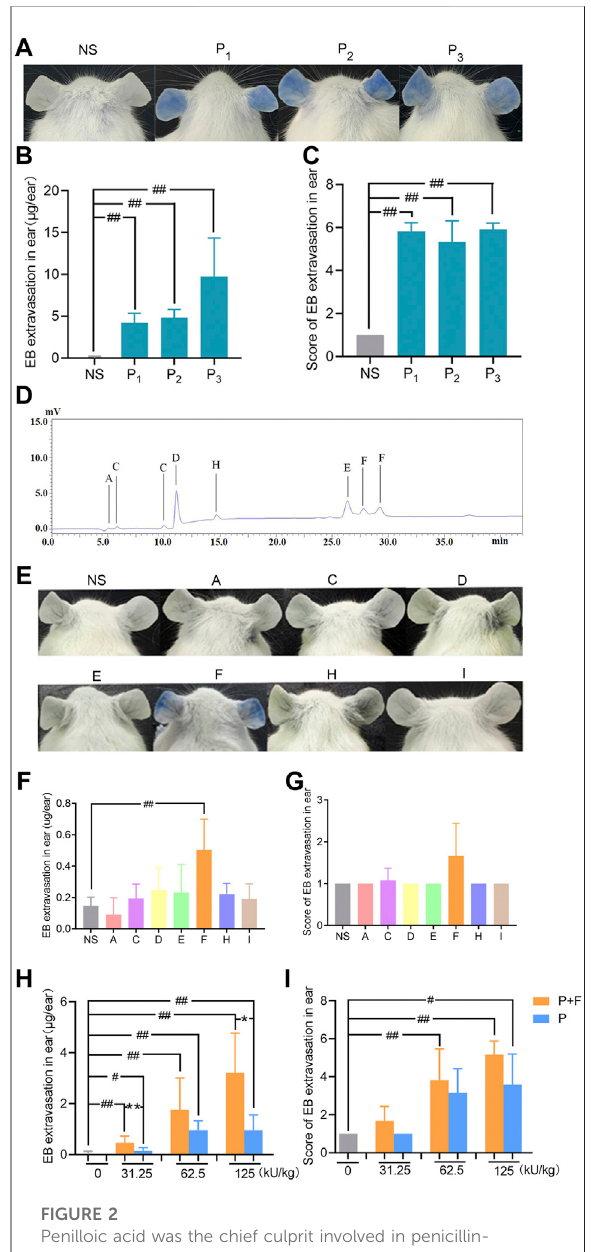
FIGURE 2 | of EB staining in the ears ( n = 6). (H,I) Penilloic acid aggravated vascular leakage induced by penicillin ( n = 6). P +